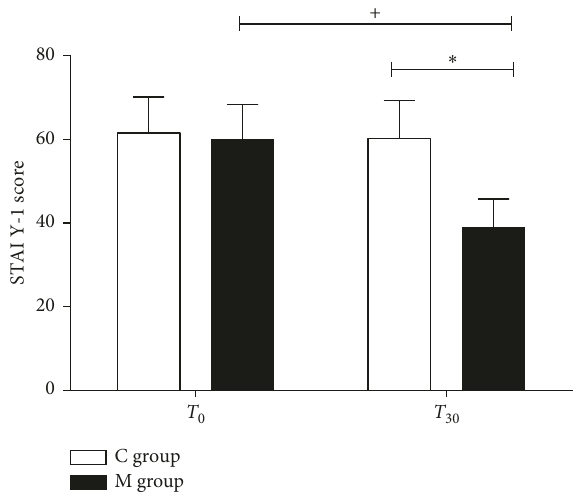
Figure 3: State Trait Anxiety Inventory Questionnaire score. State Trait Anxiety Inventory Questionnaire (STAI Y-1) score in the music group (M group) and control group (C group) at T 0 and T 30 .